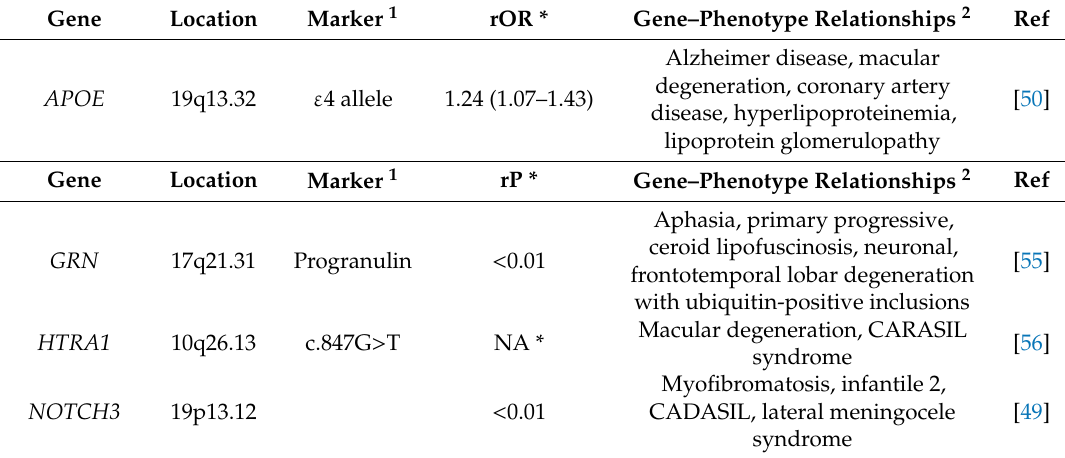
Table 3. Genes Associated with both to White Matter Hyperintensities and